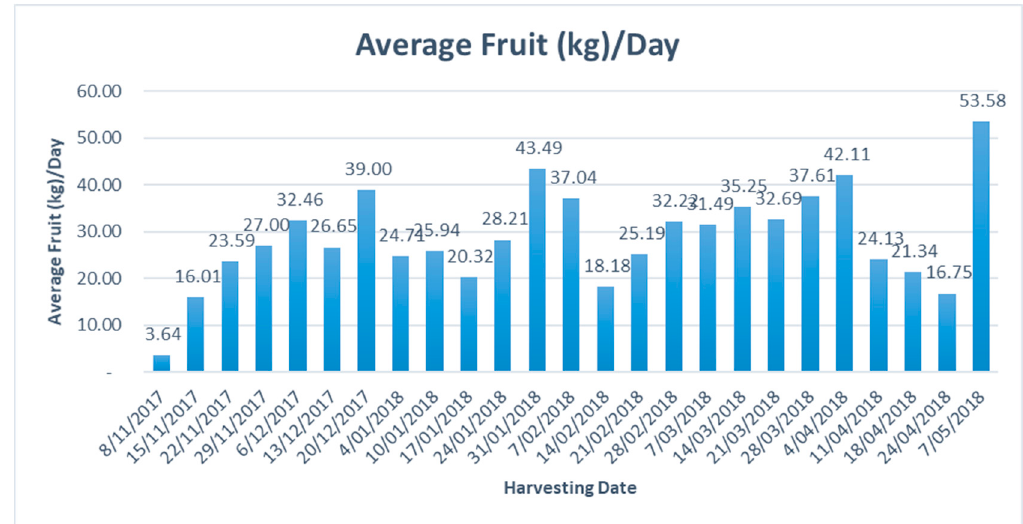
Figure 9. Calculated daily average fruit yield of the capsicum crop in a high-tech greenhouse over the 2017–2018 growth season in Richmond, New South Wales. The value at 7 May 2018 was the average fruit yield per gutter of the final harvest, which is the highest due to the inclusion of all fruits from the crop.